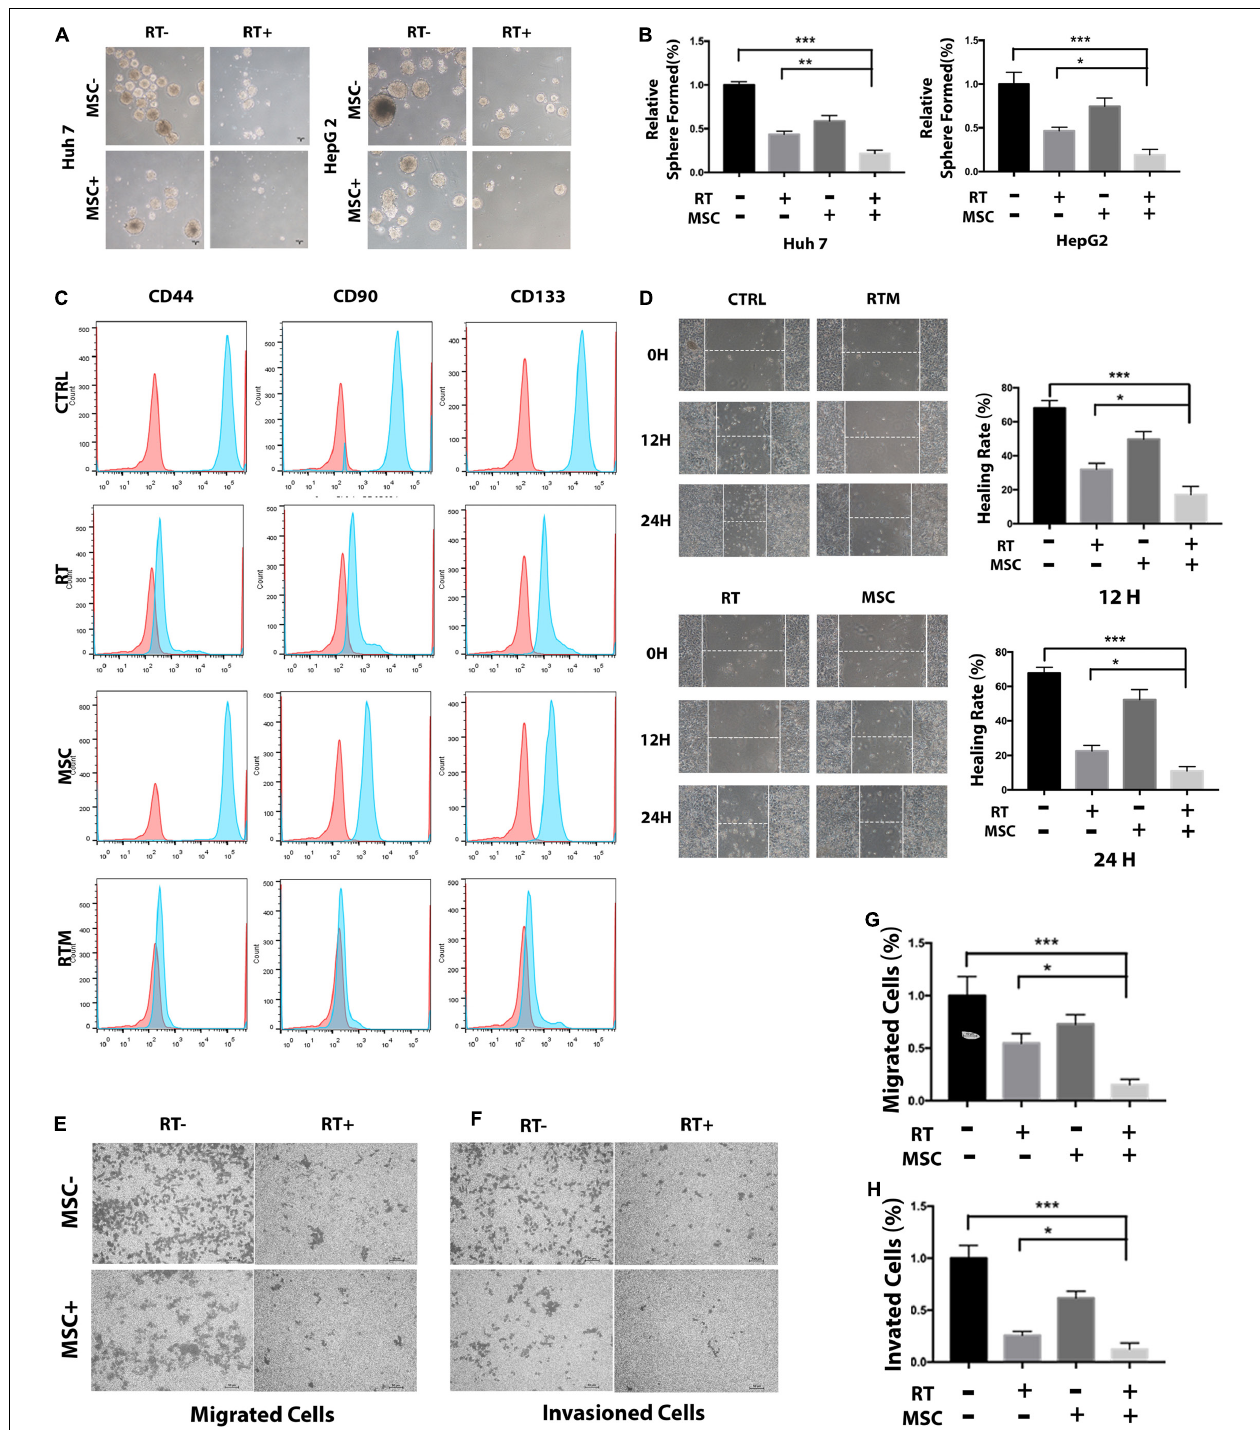
FIGURE 3 | AT-CM in combination with RT against HCC cells colony-forming, wound-healing, migration, and invasion. (A,B) The colony-formation assay showed decreased tumorigenicity in Huh7 cells, which treated with RT and AT-CM combination therapy. The graph shows the mean integrated density of colonies normalized by 100%. (C) Tumor cells exposed to irradiation with or without AT-CM were fixed and then CD44, CD90, and CD133-positive cells were analyzed with FACS. Data are from representative experiments repeated at least three times. (D) Representative wound healing assays (12 and 24 h) after scratching (0 h) demonstrated that the combination treatment reduced the wound closure ability of Huh7 cells. Representative images are shown (magnification 100 × ). (E–H) Transwell migration and invasion assays were performed to compare the motility of HCC cells treated with RT with or without AT-CM. The numbers of migrated (top) and invading (bottom) cells were calculated and are depicted in the bar chart ( ∗ P < 0.05, ∗∗ P < 0.01, ∗∗∗ P < 0.001).